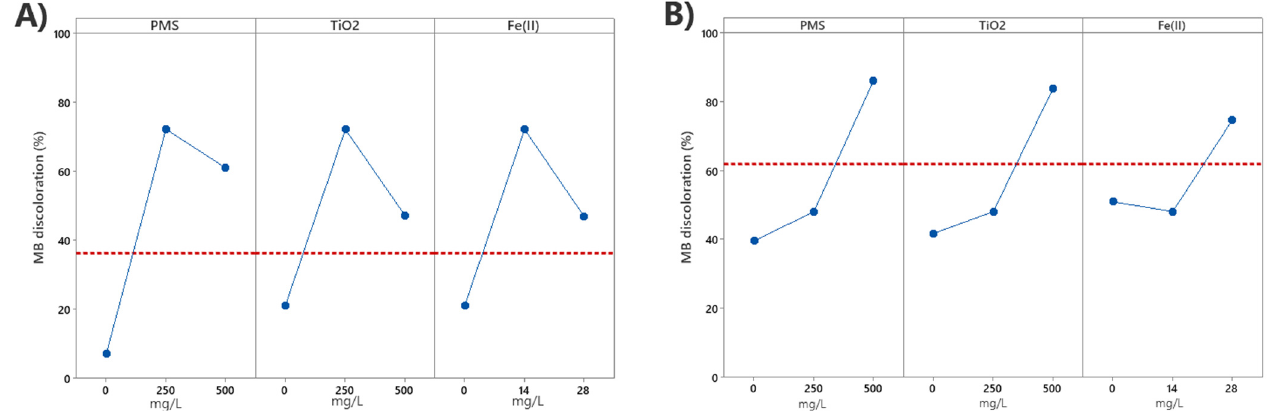
Figure 5. Main effects plot for MB discoloration using ( A ) UV-A radiation; ( B ) UV-C radiation.